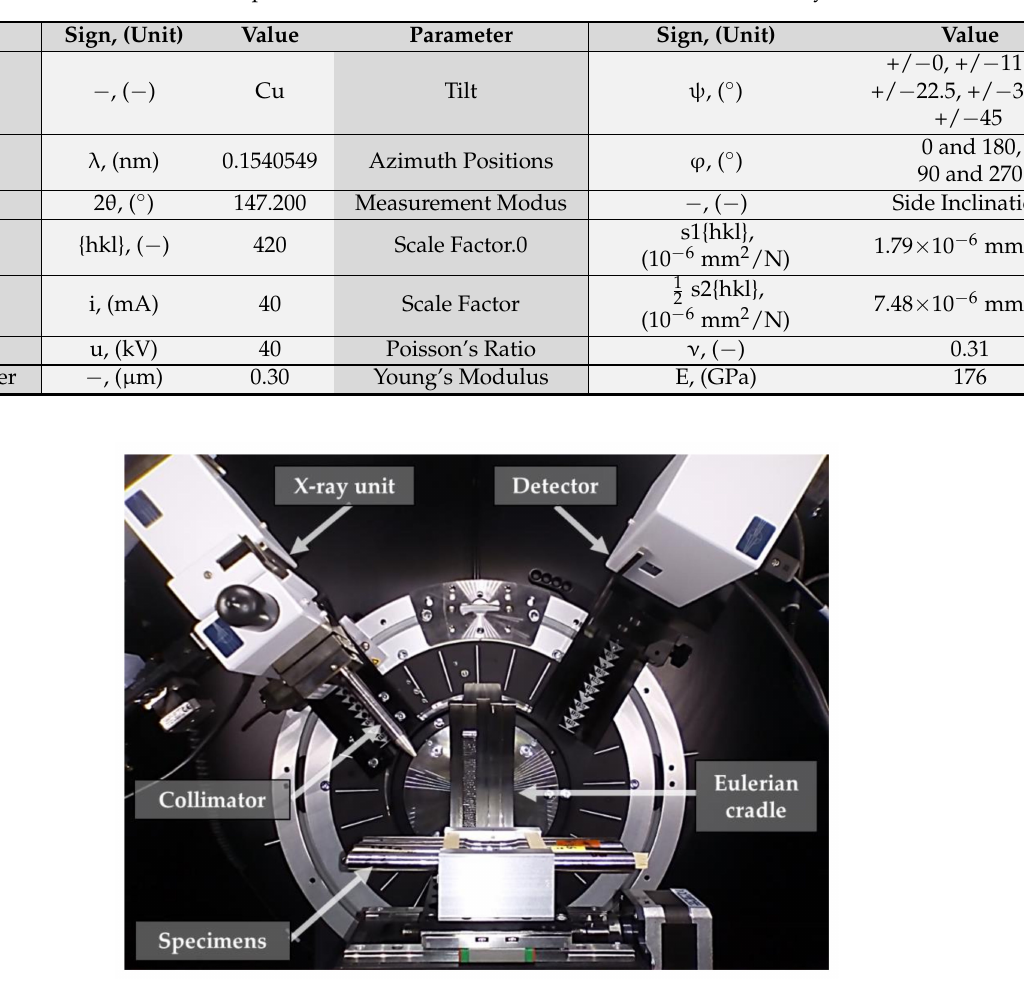
Figure 3. Experimental setup of the X-ray diffractometer.